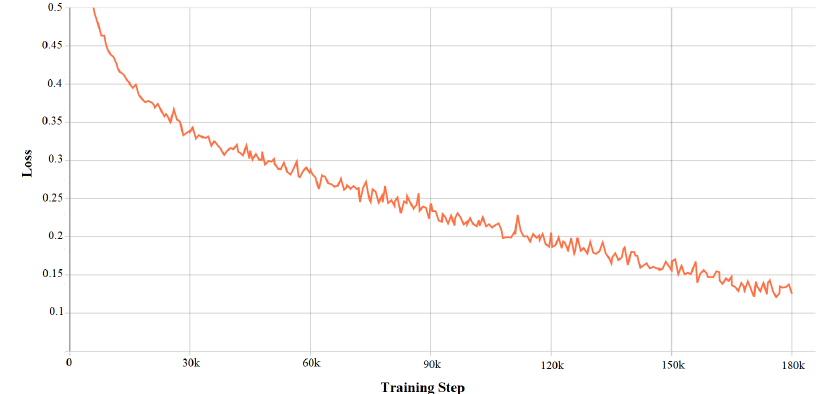
Figure 19. Characteristics of DDQN hyper-parameters: loss validation.